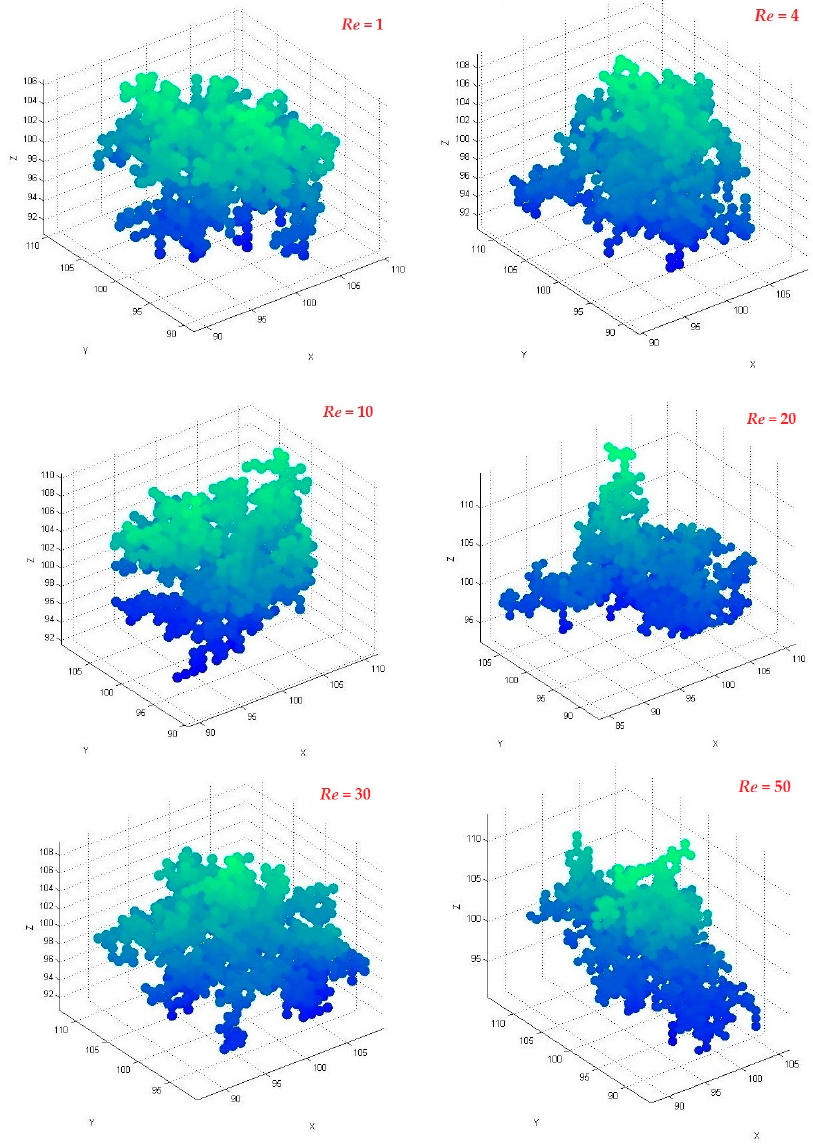
Figure 9. 3D DLA aggregates with various launch radii.